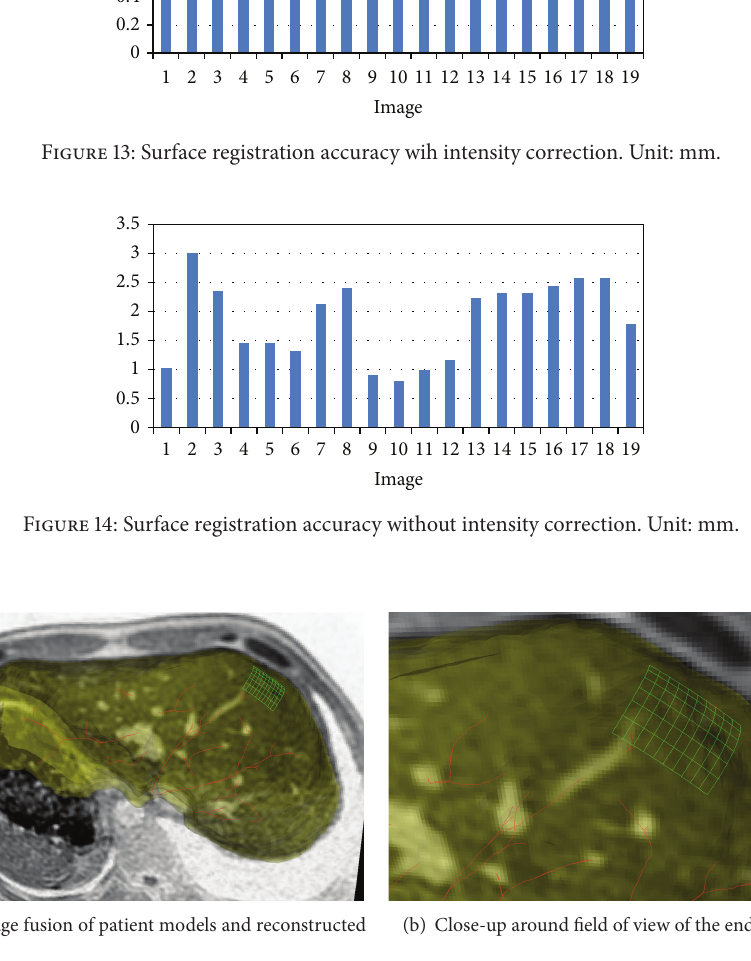
Figure 15: Fusion of patient models and reconstructed surface from the stereo endoscope. Green mesh is the reconstructed surface from two endoscopic images, red curves are the centerlines of vessels, segmented surface from MR images is shown in semitransparent yellow, and background is one MR slice with bright